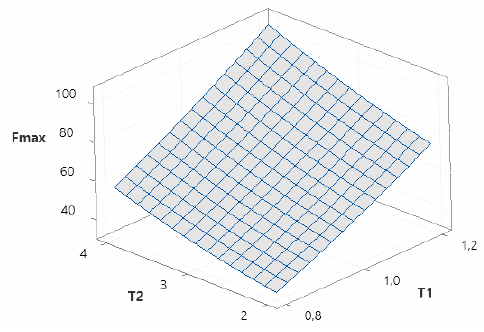
Figure 14. Surface plot of F max and T 1 ; T 2 (for L = 11 mm)